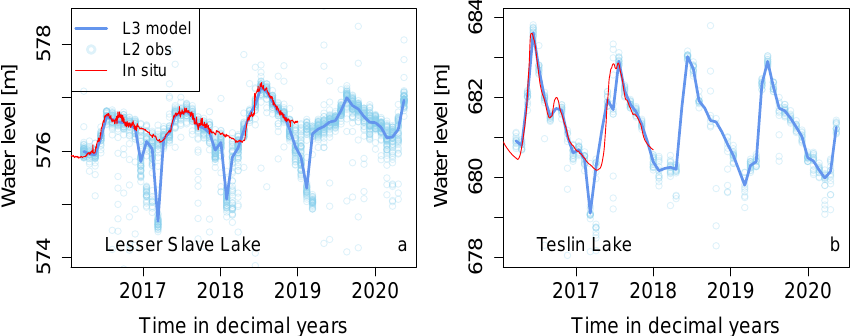
Figure 5. Typical lake level time series for Canadian lakes ( a ) Lesser Slave Lake and ( b ) Teslin Lake. In a few cases, for example, for Lake Kiskittogisu and Nonacho (Figure 6), we find an RMSE value above 2 m. For Lake Kiskittogisu (track number 317) the water level deviates from the in situ data by a few meters in some cycles, which leads to an incorrectly reconstruction of the water level time series. For Lake Nonacho (track number 360) the water level measurements span a large elevation range without a clear indication of a distinct surface leading to a complete failure of the time series model. As a reference Figure 6 also shows a track for the same lakes where the water level time series is correctly reconstructed.